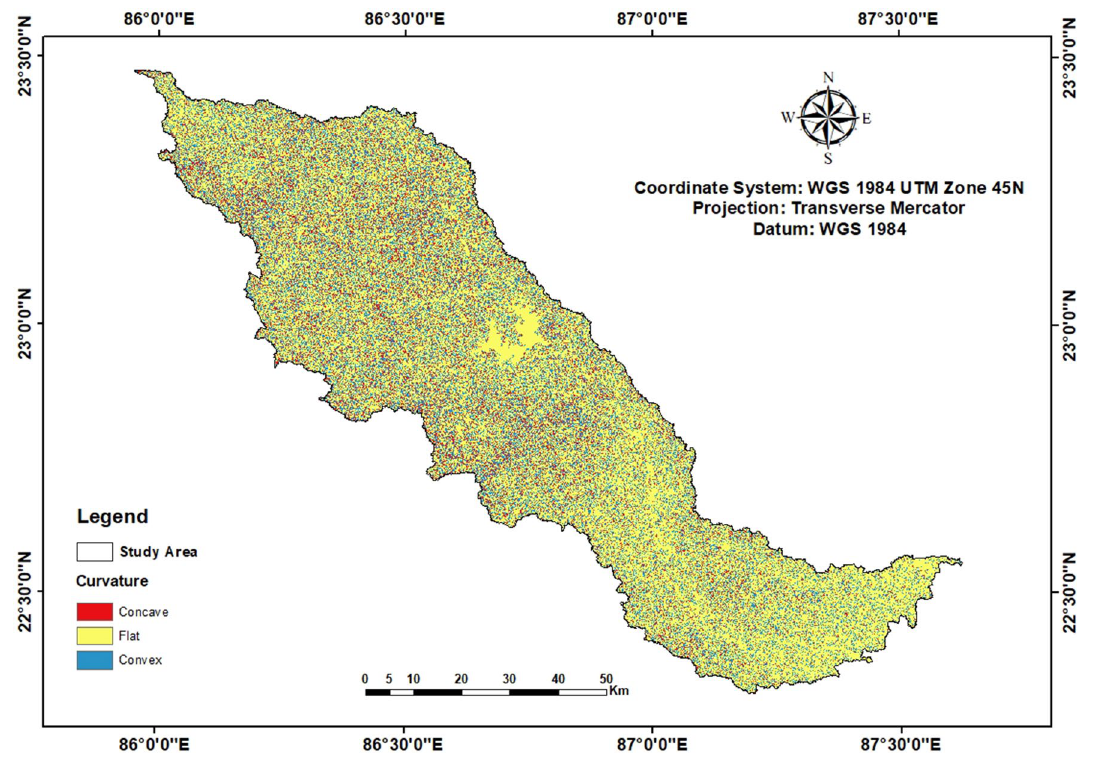
Fig. 12 Curvature map showing spatial distribution of different slope types in Kangsabati River